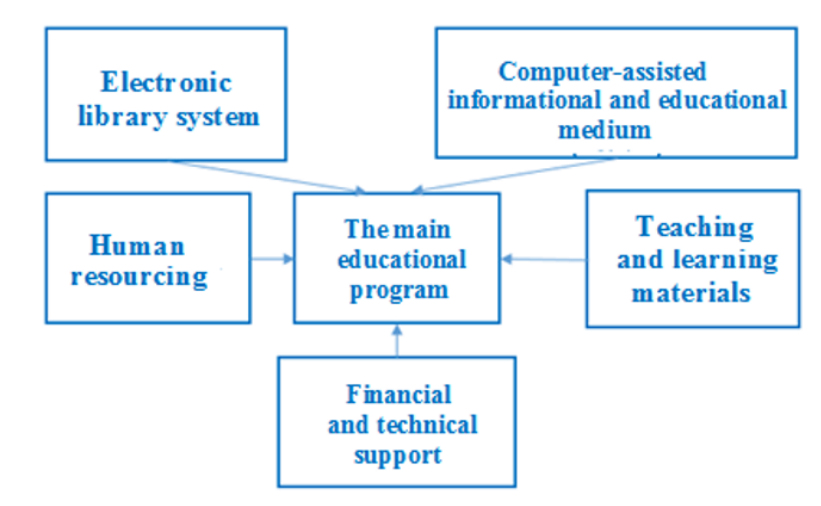
Fig. 4. List of requirements for the MEP